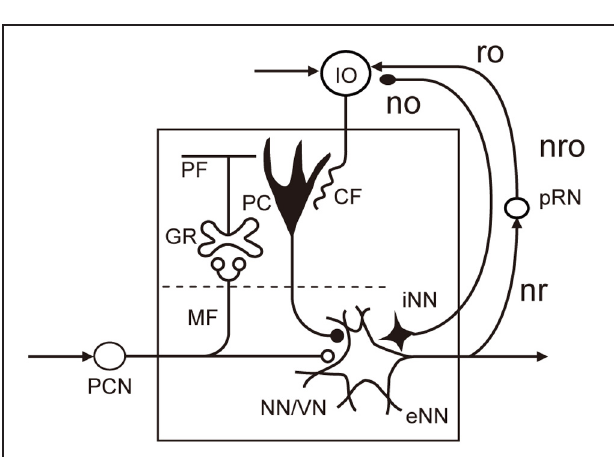
FIGURE 1 | Two types of adaptive control system. (A) Without online feedback. (B) With online feedback. Pathways for computing error signals are indicated by red lines.